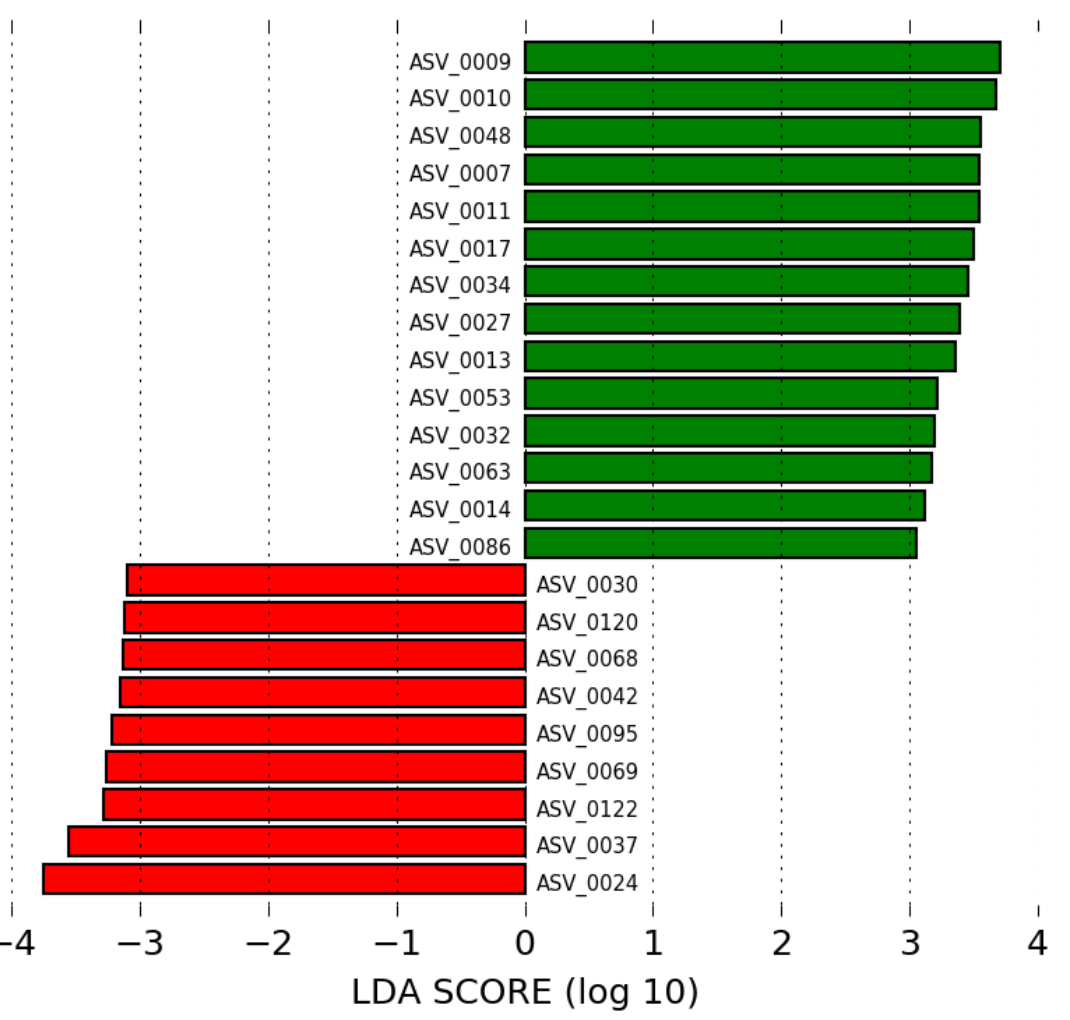
Figure 2. LEfSe analysis between the overweight/obese ( green ) and lean ( red ) groups (LDA score > 3.0). The LDA score (log10) for the most prevalent ASV in the overweight/obese group is represented on a positive scale and the LDA score for the most prevalent ASV in the lean group is represented on a negative scale.